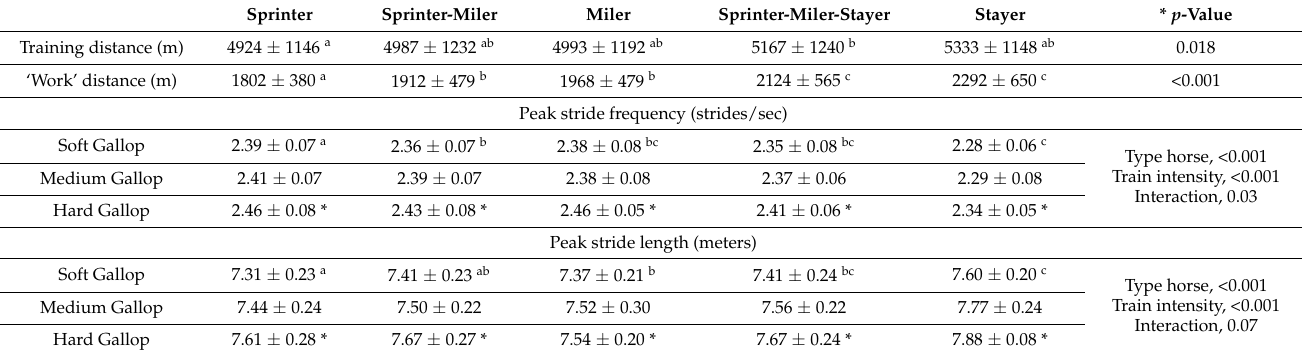
Table 3. Peak stride frequency and length in race-speed training efforts categorised by type of